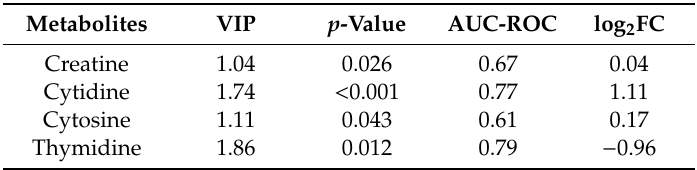
Table 2. Metabolites contributing to the discrimination between the exercising and non-exercising groups at 12 months. (See Table 1 for